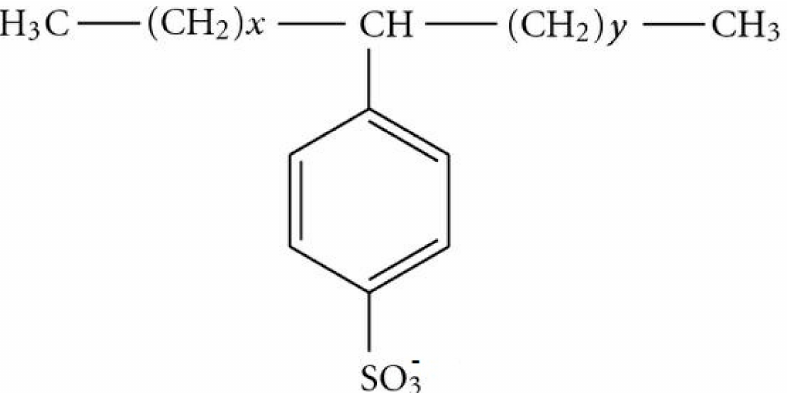
Figure 1. Structure of the anionic surfactant linear alkylbenzene sulfonate (LAS) with hydrophobic (alkyl chain) and hydrophilic (sulfonate) moieties. The C 10 –C 13 LAS homologues are characterized by x + y =